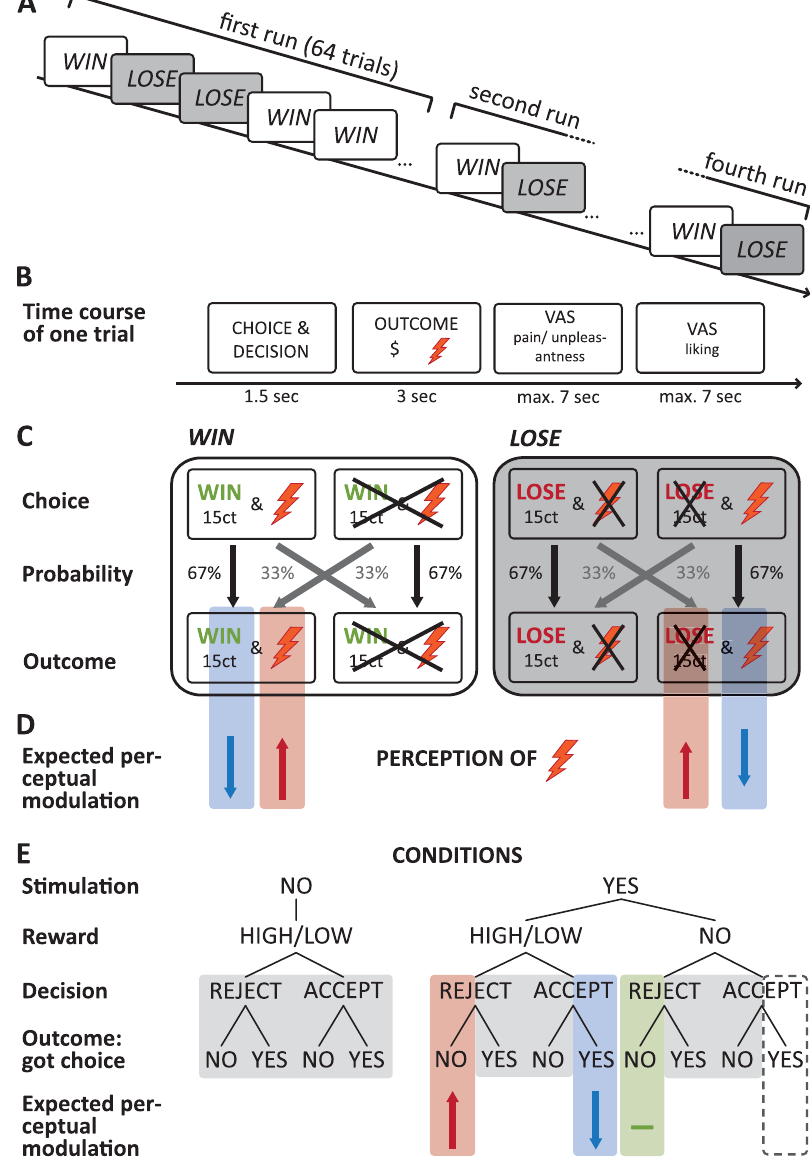
Figure 1. The decision-making task. ( A ) In four runs of 64 trials each, participants performed win and lose trials in pseudo-randomized order. ( B ) Time course of one trial: At the beginning of each trial the possible choices were displayed and participants indicated their decision, followed by the presentation of the outcome. If an electrocutaneous stimulus was applied, participants rated how painful and/or unpleasant they perceived this stimulus on a VAS. Subsequently, participants rated in each trials how much they liked the monetary outcome of the trials on a VAS. After a short break (1 sec) the next trial started. ( C ) In the win trials, participants had to decide whether they wanted to receive a monetary win at the cost of simultaneously receiving a nociceptive stimulus or to reject the win at the benefit of avoiding the pain. In the lose trials, participants had to choose between a monetary loss at the benefit of avoiding a nociceptive stimulus or rejecting the loss at the cost of receiving the stimulus. In both trial types, participants received their choice in 67% of the trials (outcome). ( D ) Decreased perceived intensity (blue shading) was expected if participants accepted the monetary win coupled to the nociceptive stimulus or when they rejected the loss coupled to the nociceptive stimulus. Increased perceived intensity (red shading) was expected if participants rejected the monetary win to avoid the nociceptive stimulus or when they accepted the loss to avoid the stimulus. ( E ) Coding of conditions for the statistical analyses: Trials with and without electrocutaneous stimulation could be coupled to low or high reward (in terms of receiving a monetary win or avoiding a monetary loss). Trials with stimulation could be also coupled to no (zero) reward. Participants could accept or reject the reward coupled to the electrocutaneous stimulation and they could get (67%) or not get (33%) their choice. Shaded areas indicate trials with no stimulation. Only for trials with stimulation effects on perceived pain could be analysed. Blue shading indicates the condition for which decreased perceived intensity was expected, red shading increased perceived intensity. Green shading indicates the control condition. The condition highlighted by a dotted line, indicates trials that were excluded from the main analyses because of low